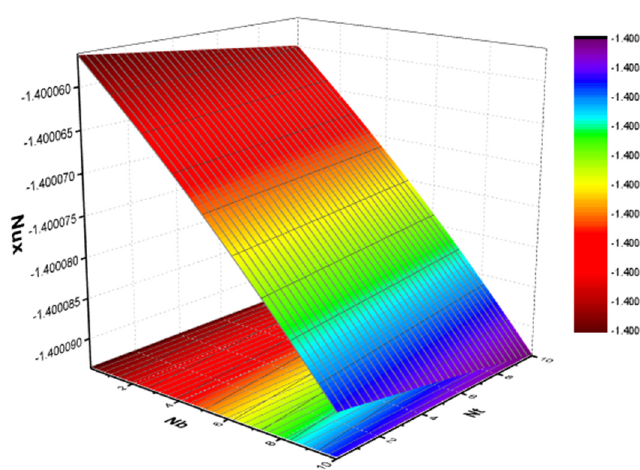
Cf M A and on x . Cf M A and on x .